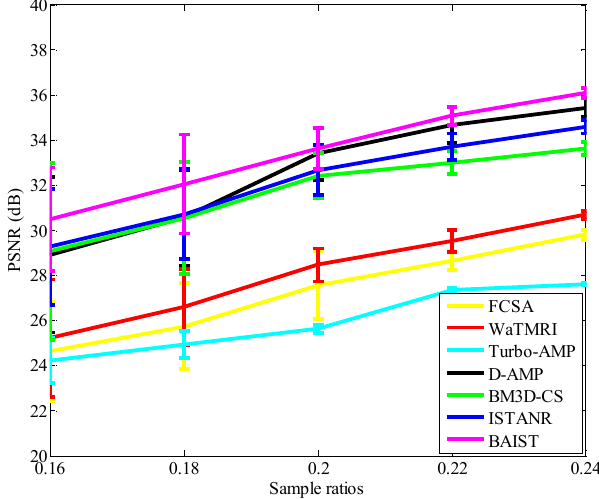
Figure 4. Average PSNR on boat image at different sample rates.